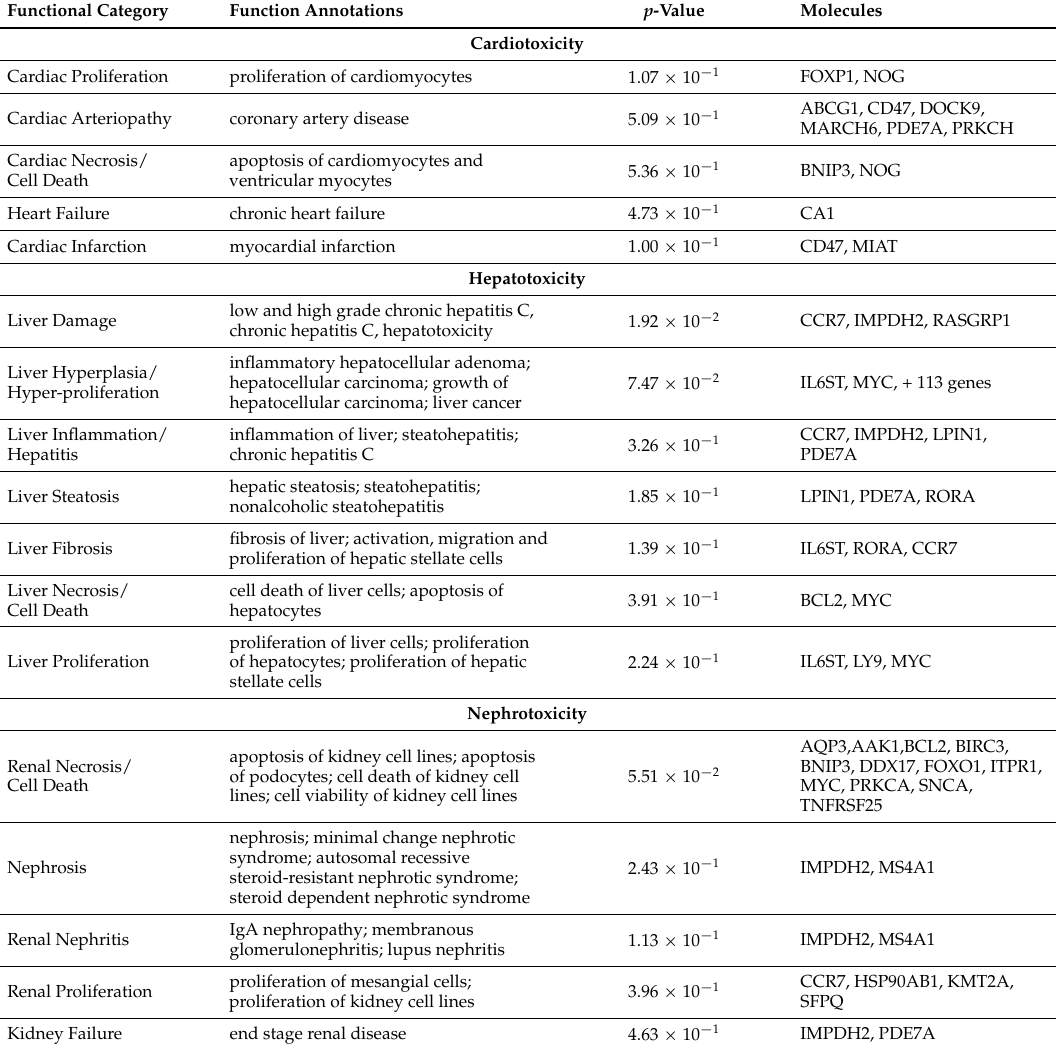
Table 3. Functional annotations and molecules involved in toxicity (cardiotoxicity; hepatotoxicity; nephrotoxicity) resulting from radiation